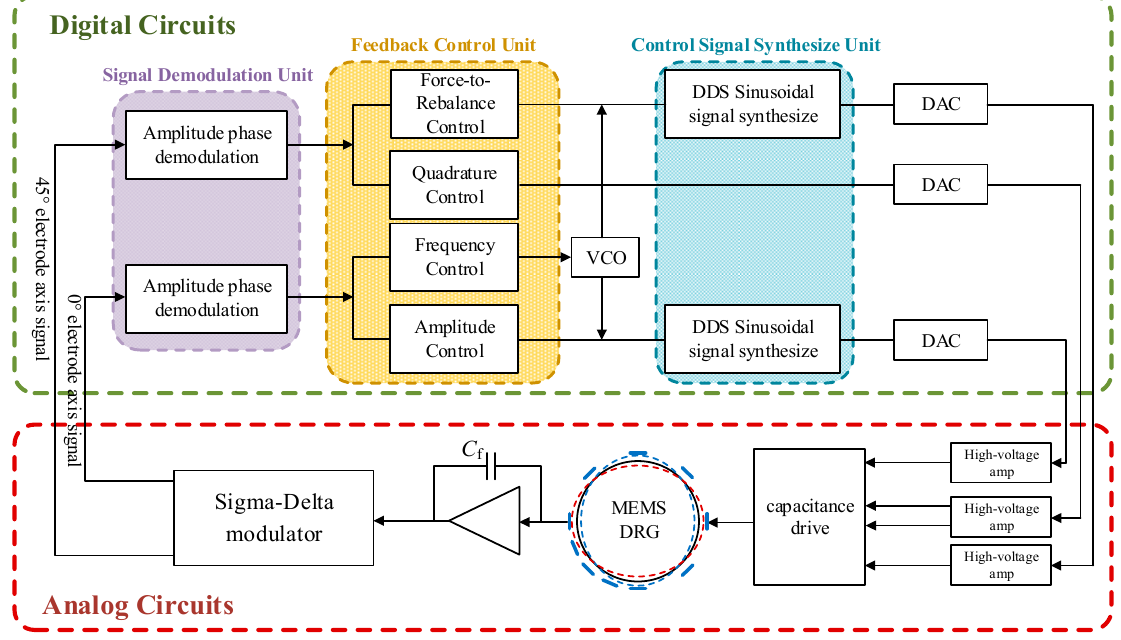
Figure 3. Overall scheme of DRG control circuit.